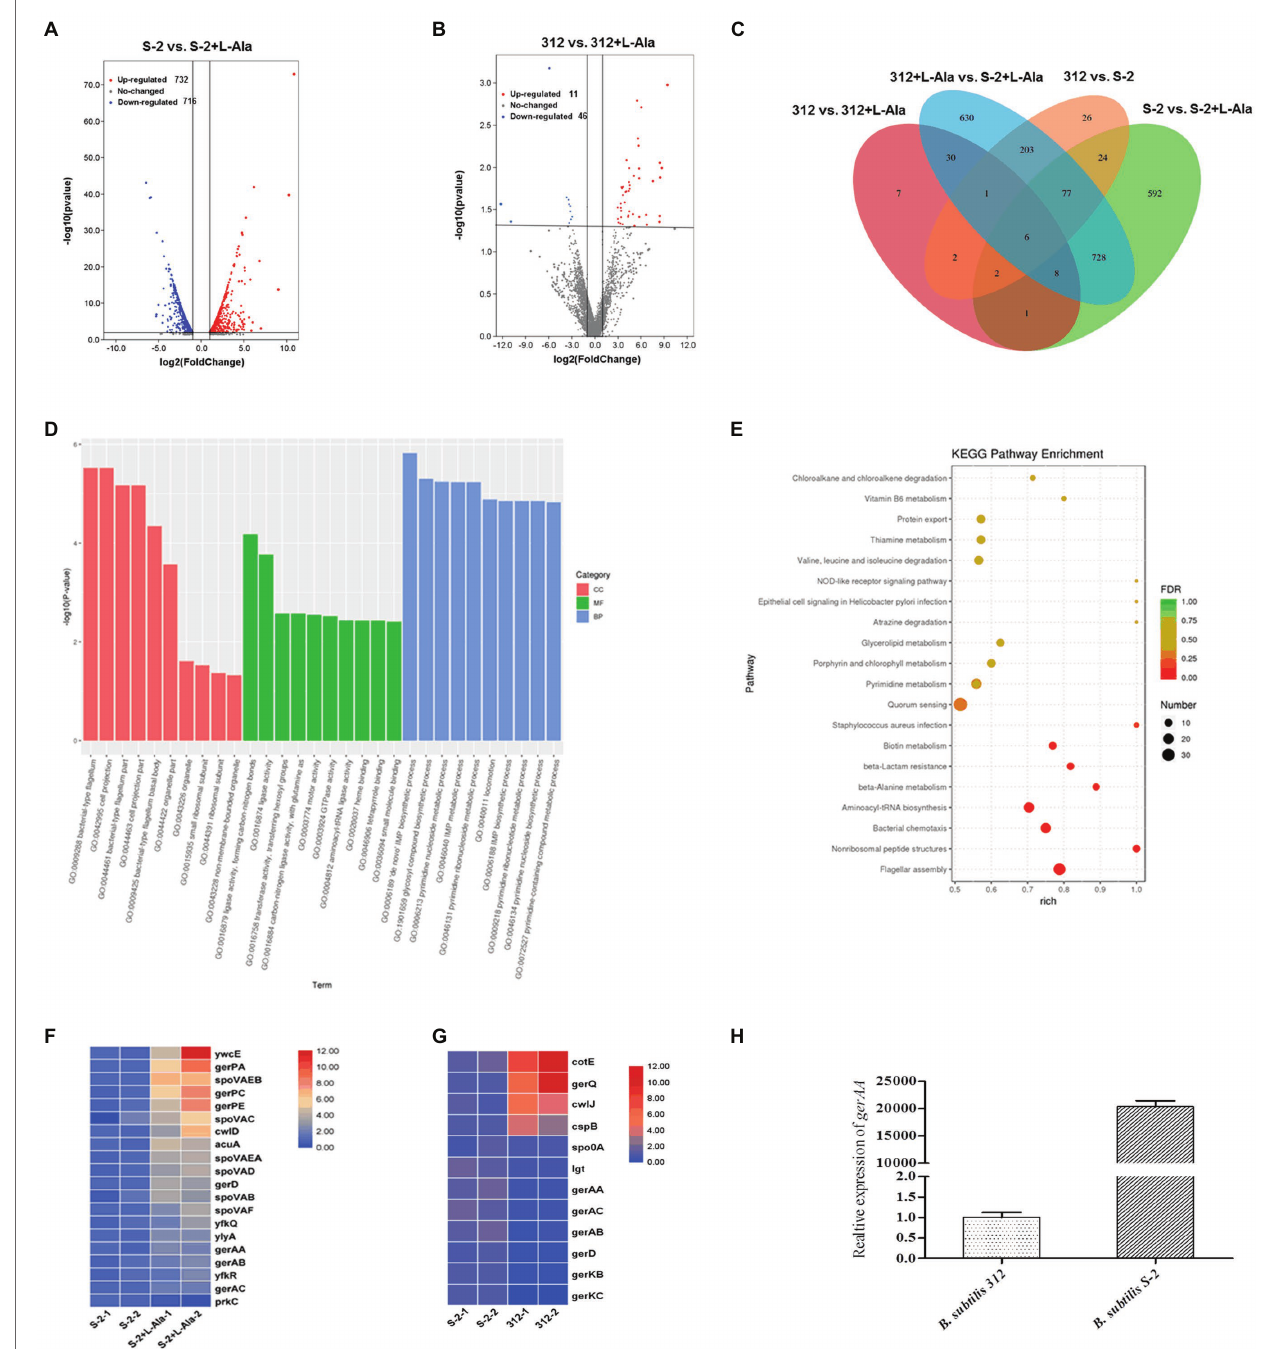
FIGURE 4 | Comparative transcriptome analysis of B. subtilis S-2 and 312 strains in response to L-alanine. (A) Volcano plot of differently expressed genes (DEGs) between B. subtilis S-2 spores and L-alanine pre-treated B. subtilis S-2 spores. (B) Volcano plot of DEGs in B. subtilis 312 spores and L-alanine pre-treated 312 spores. (C) Venn diagram of the numbers of DEGs between 4 groups. (D) GO analysis of the DEGs between B. subtilis S-2 spores and L-alanine pre-treated B. subtilis S-2 spores. (E) GO analysis of the DEGs between B. subtilis 312 spores and L-alanine pre-treated B. subtilis 312 spores. (F) DEGs enriched in spore germination pathway between B. subtilis S-2 spores and L-alanine pre-treated B. subtilis S-2 spores. Each row represents one gene, and each column represents one sample; Red indicates high expression, and blue represents low expression. (G) DEGs enriched in spore germination pathway between B. subtilis S-2 and B. subtilis 312. Each row represents one gene, and each column represents one sample; Red indicates high expression, and blue represents low expression. (H) The expression level of gerAA in B. subtilis S-2 and 312